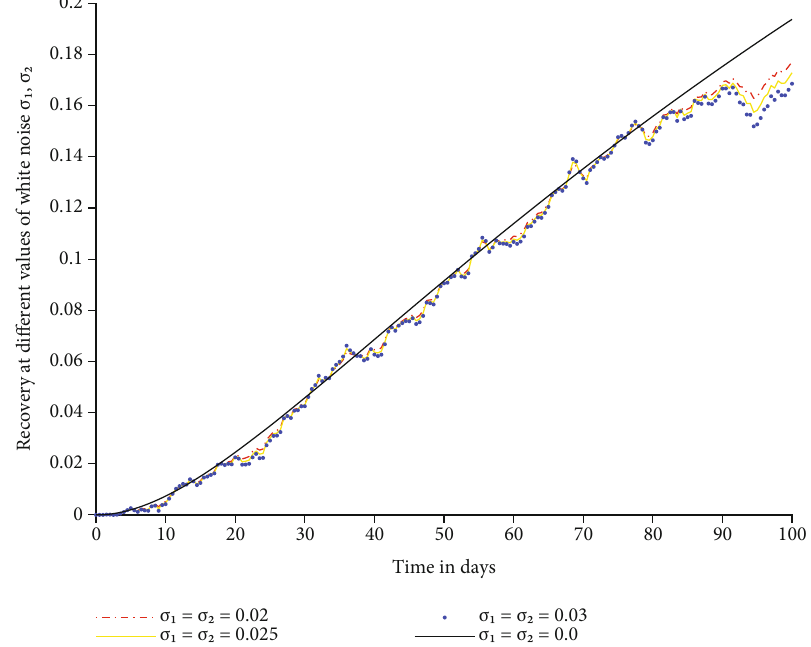
Figure 3: Joint solution of the given model (1) of COVID-19 for the order 0.98.